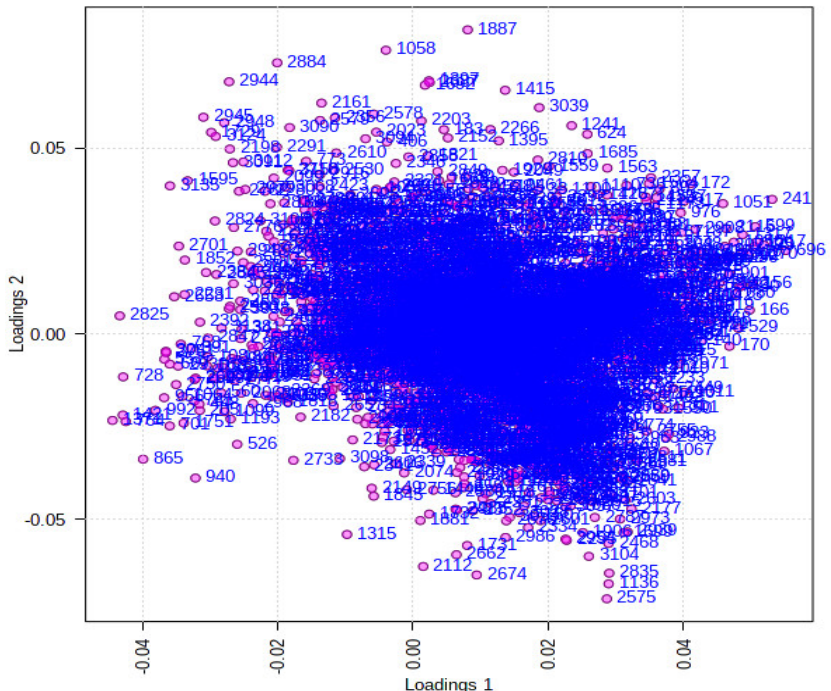
Figure 8. PLS-DA loading plot in supervised analysis obtained from DFC and DFS. Shown data are the Var ID (peak number).